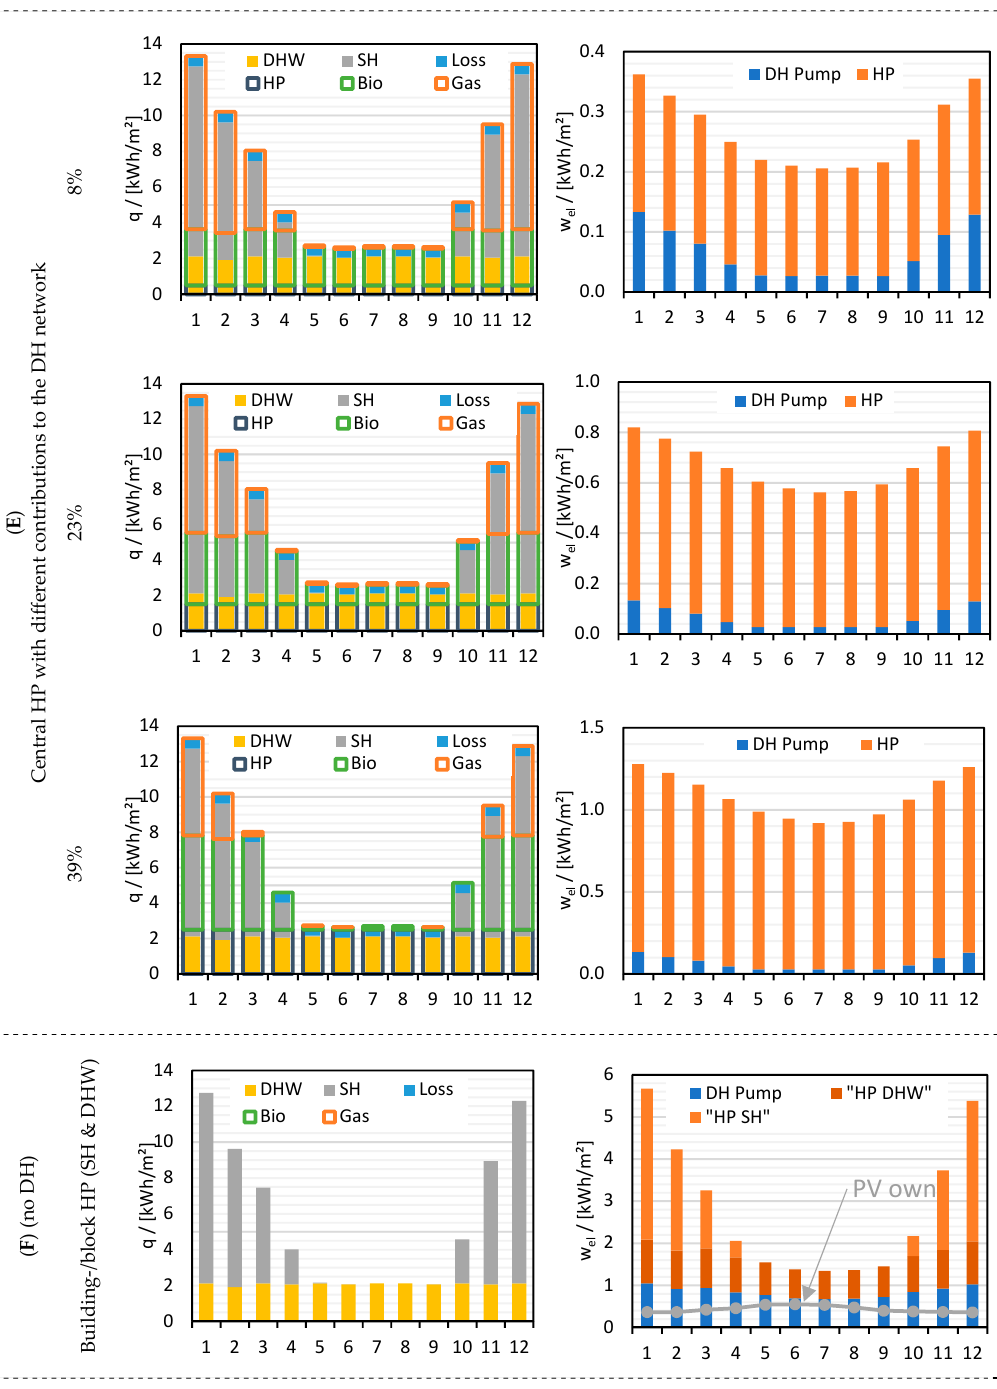
Figure 15. Thermal balance ( left ) and electric balance ( right ) of all the analysed possibilities for HP integration on the DH network.